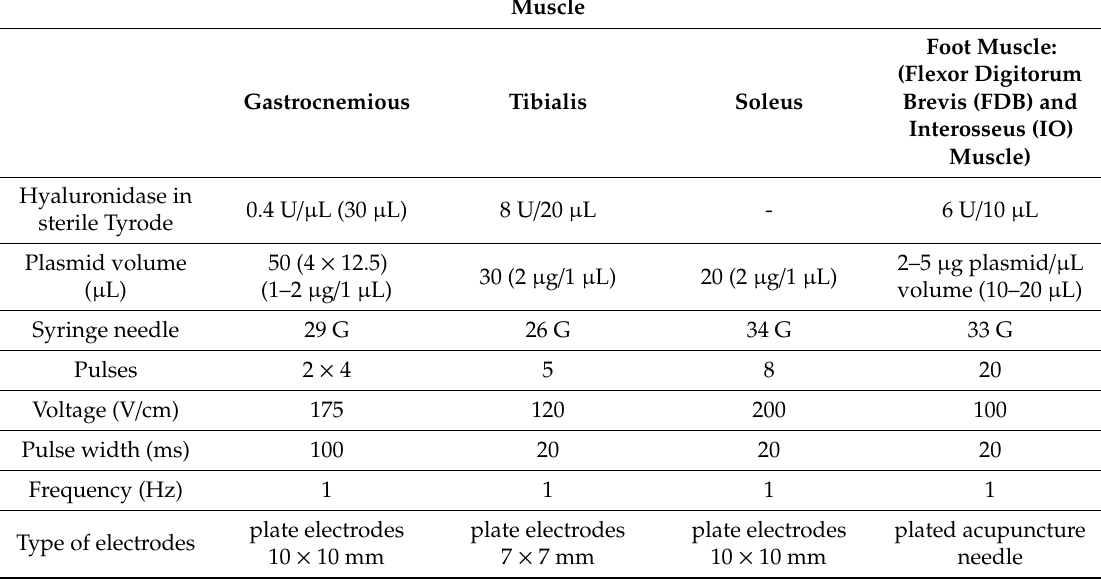
Table 3. Parameters of electroporation. Depending on the electroporated tissue, the volume and concentration both hyaluronidase and plasmids suspension, as well as the number of applied pulses, pulse width, applied voltage and the type of electrode will di ff er. Muscle Gastrocnemious Tibialis Soleus